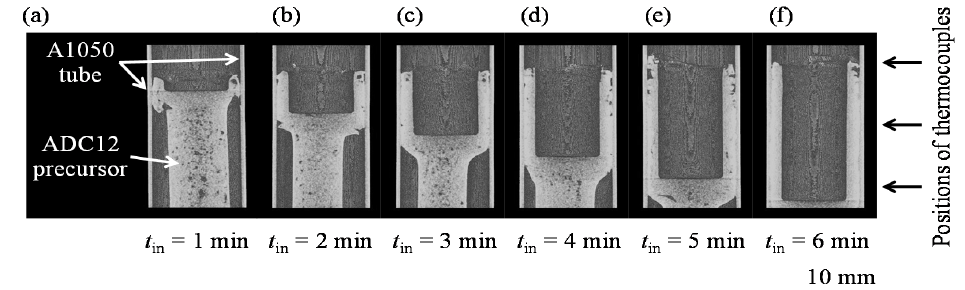
Figure 1. X ‐ ray CT deformation images of the ADC12 precursor during friction welding with various tool indentation times t in . ( a ) t in = 1 min; ( b ) t in = 2 min; ( c ) t in = 3 min ( d ) t in = 4 min; ( e ) t in = 5 min; ( f ) t in = 6 min.